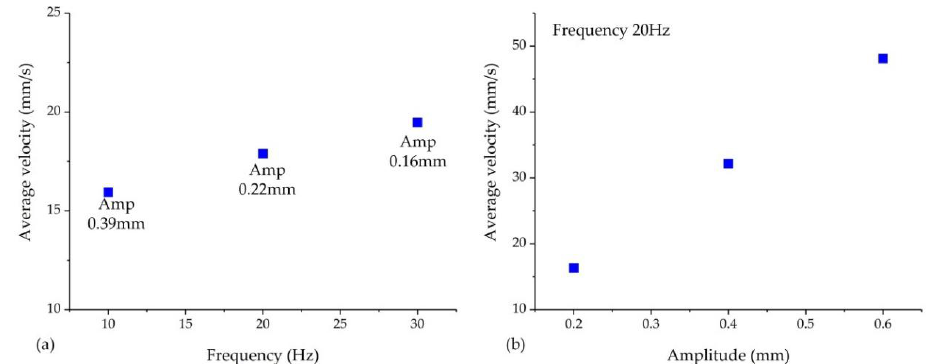
Figure 13. Influence of vibration frequency ( a ) and vibration amplitude ( b ) on the punch average velocity during vibration-assisted clutch hub forming.